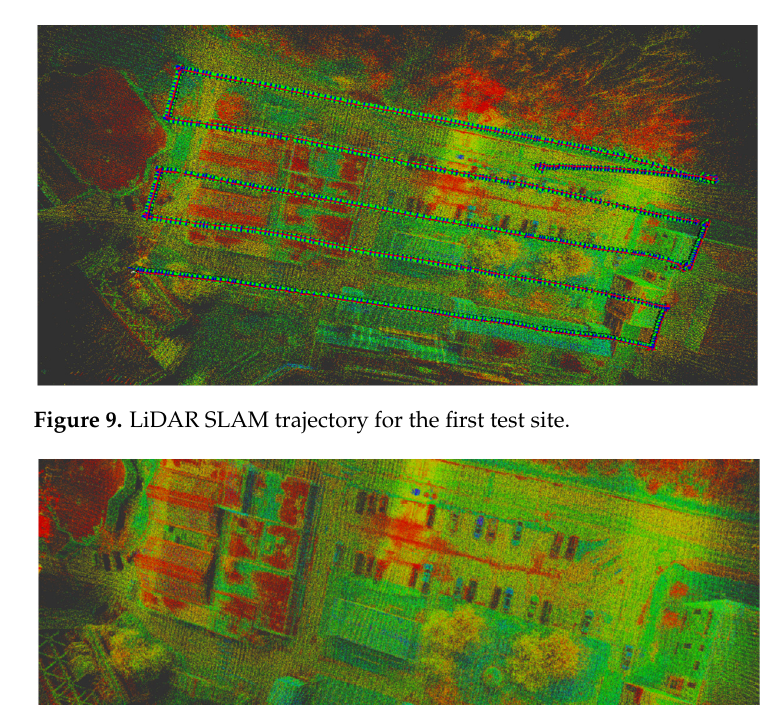
Remote Sens. 2022 , 14 , 4298 10 of 23 Figure 7. Five bands orthomosaic images of the multispectral camera for the first test site.